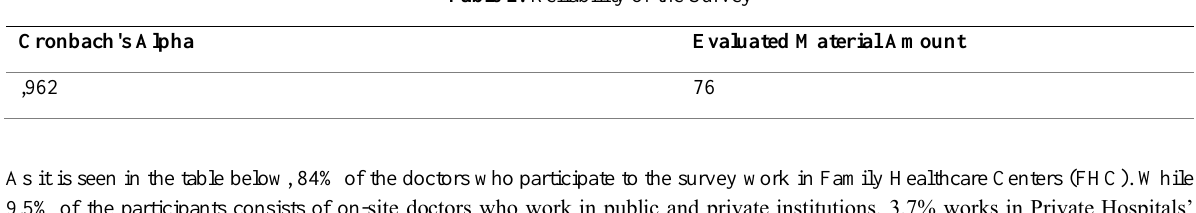
Table 2: Reliability of the Survey